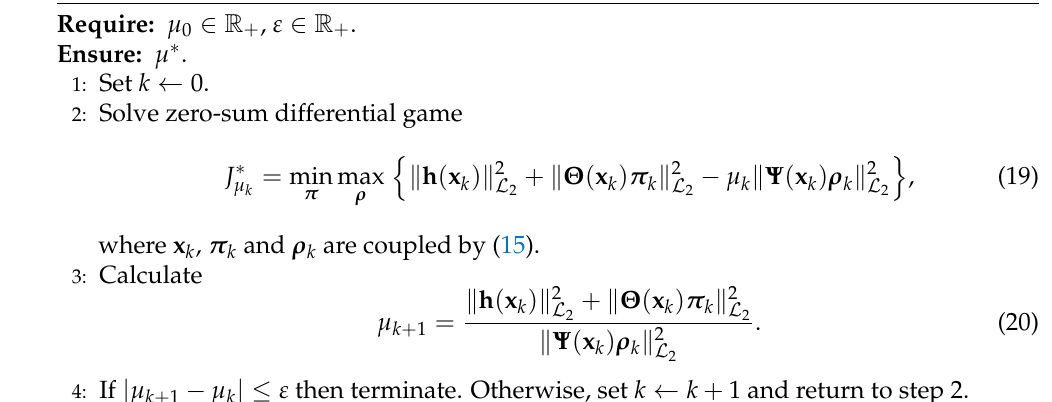
Algorithm 1 quasi-Newton method for L 2 -gain